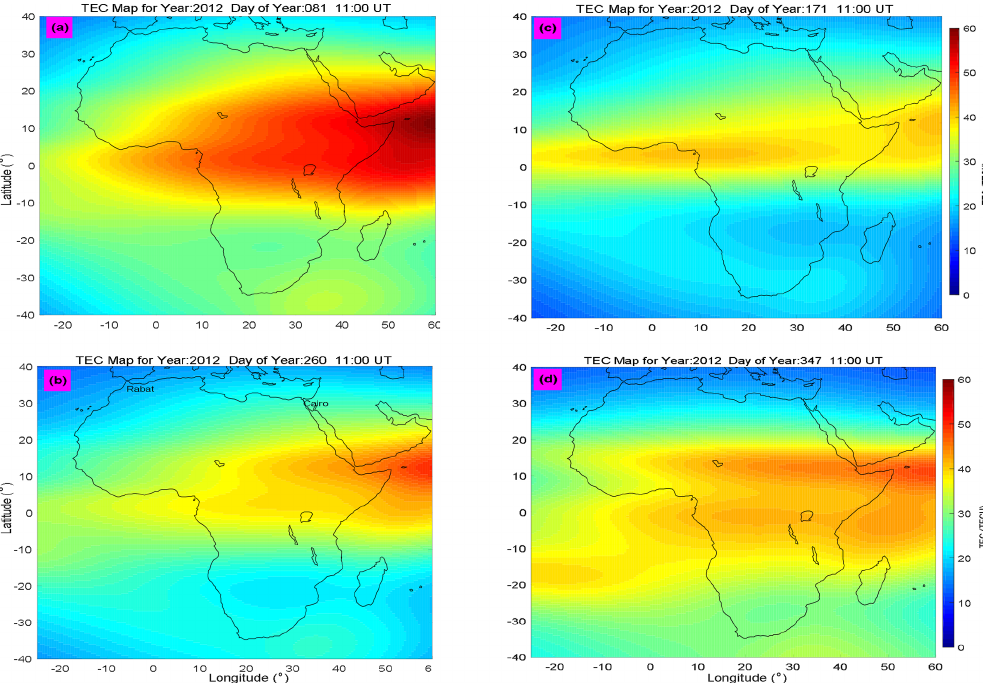
Figure 7. Neural network TEC maps during the year 2012 at 11:00UT. Panels (a) and (b) are for March (DOY 81) and September (DOY 260) equinoxes, respectively, while (c) and (d) are for June (DOY 171) and December (DOY 347) solstices, respectively.